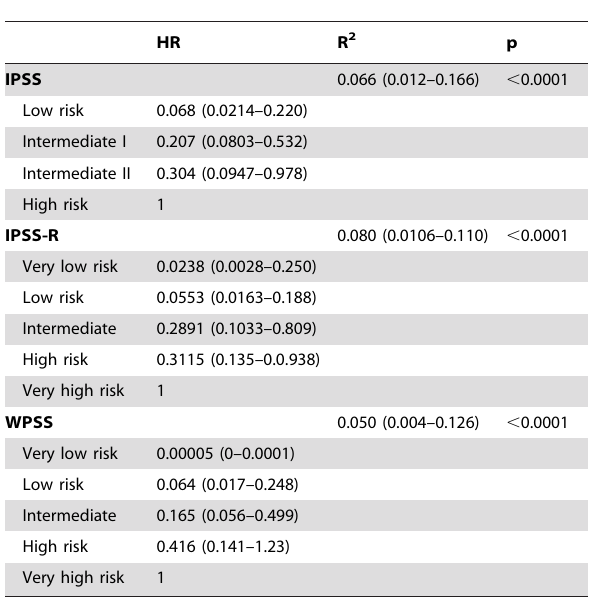
Table 5. Univariate Cox analysis of the three prognostic scores examined with 95%CI intervals for R 2 calculated by boostrap resampling (in brackets).